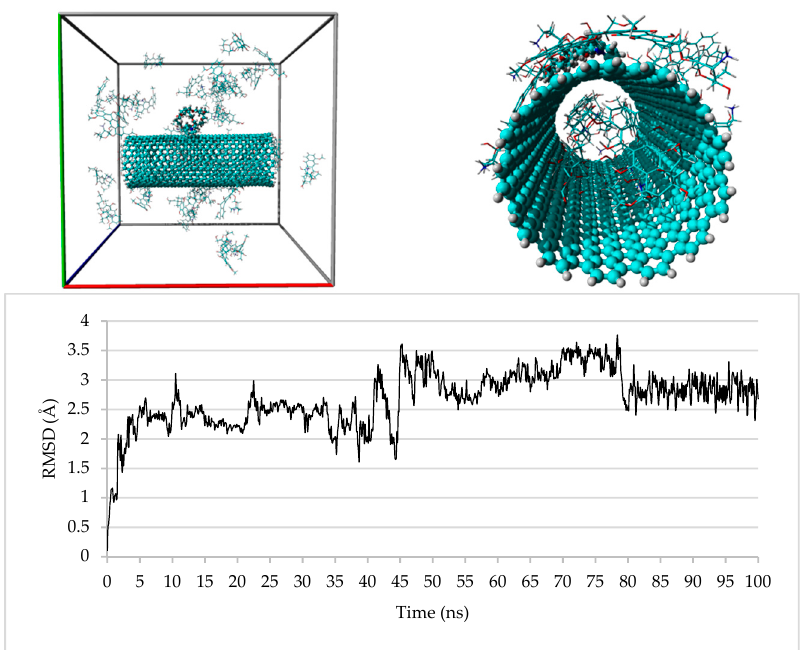
Figure 14. Upper: SSy2 at the start (left) and the end (right) of the MD simulation; bottom: plot of the RMSD of the DOX molecules during the 100 ns of the MD simulation.